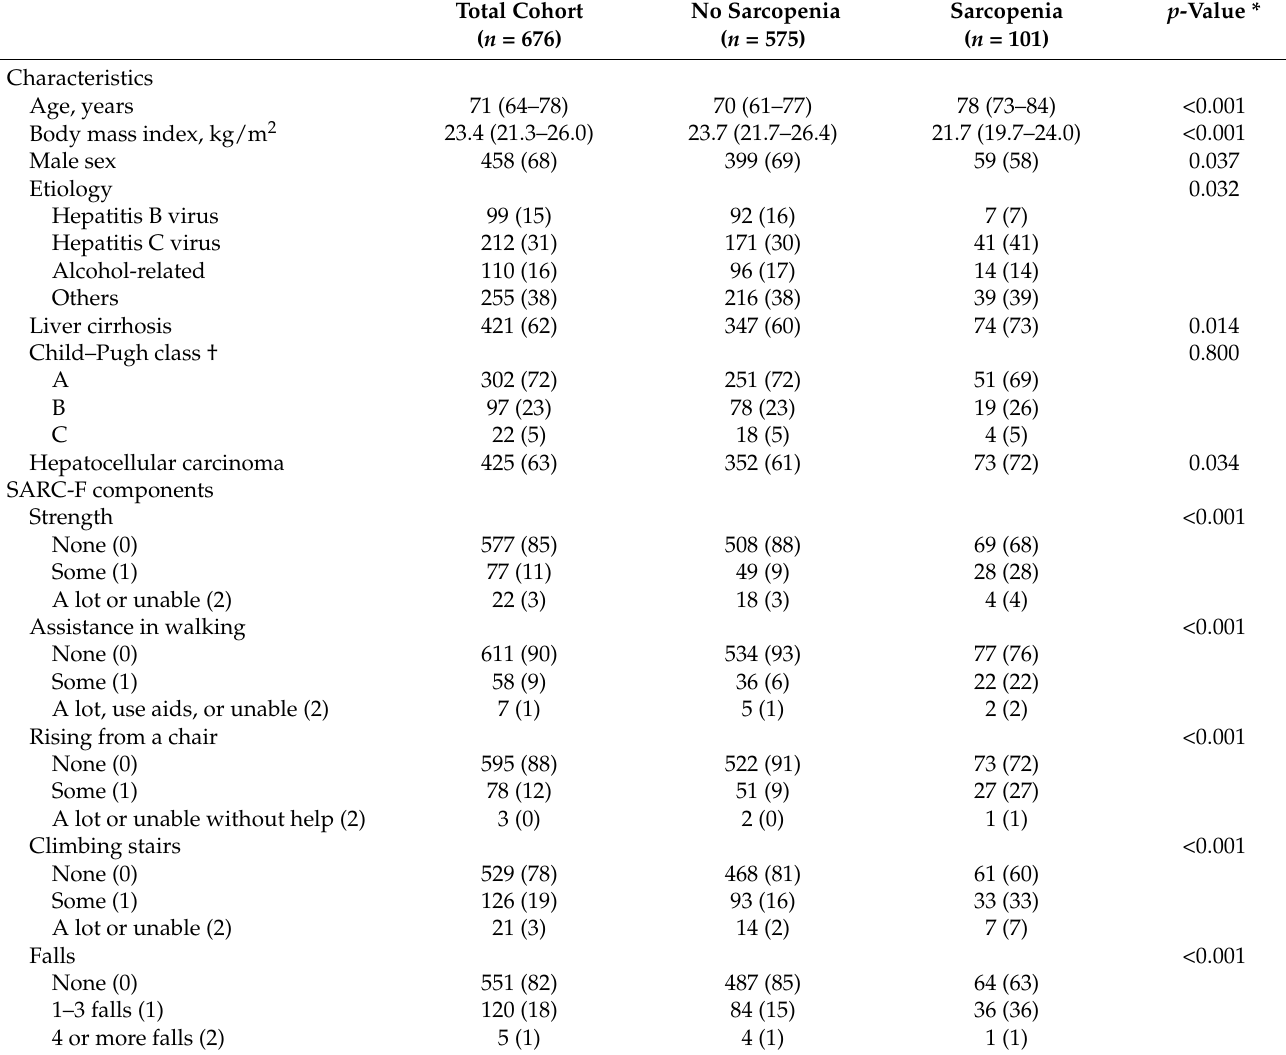
Table 1. Baseline characteristics of patients with and without